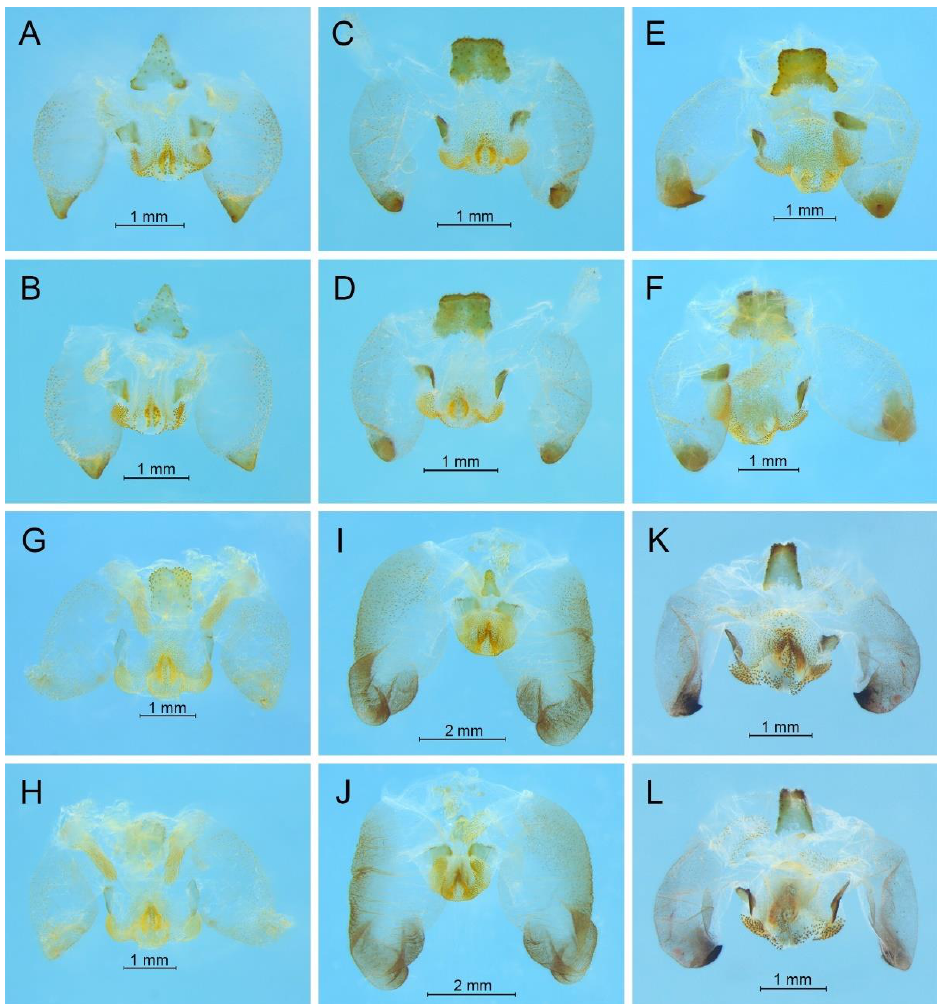
Figure 20. Male genitalia of Homotachycines . ( A , C , E , G , I , K ) dorsal view, ( B , D , F , H , J , L ) ventral view: ( A , B ) Homotachycines triangulus Zhu & Shi sp. nov.; ( C , D ) Homotachycines quadratus Zhu & Shi sp. nov.; ( E , F ) Homotachycines baokangensis Zhu & Shi sp. nov.; ( G , H ) Homotachycines fusus Zhu & Shi sp. nov.; ( I , J ) Homotachycines concavus Zhu & Shi sp. nov.; ( K , L ) Homotachycines qinlingensis Zhu & Shi sp.